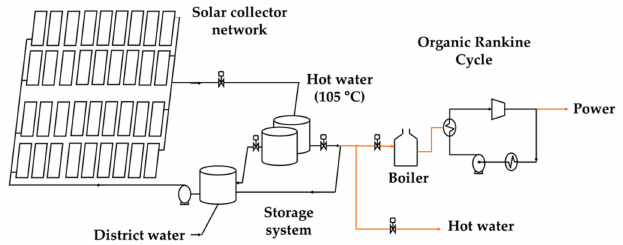
Figure 2. Basic scheme of the proposed organic Rankine